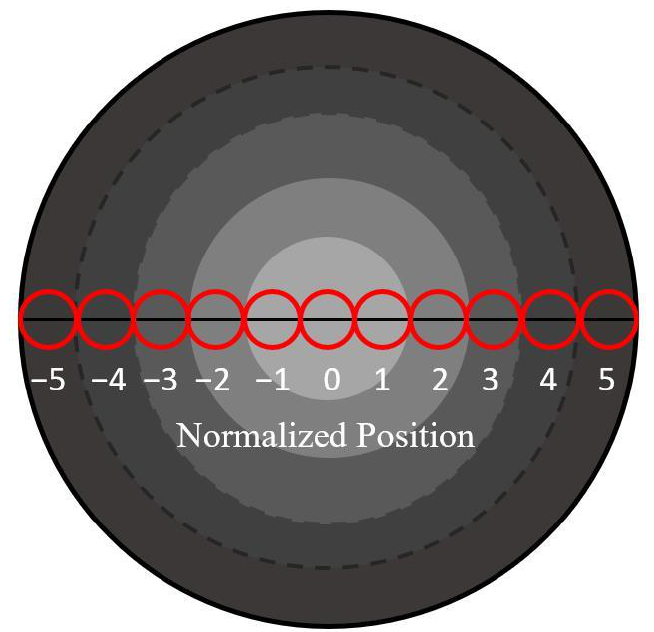
Figure 2. Schematic of radial optical density test of pre-oxidized fiber. (Note: the diameter of each filament for pre-oxidized fiber treated by precursor B was about 11 µ